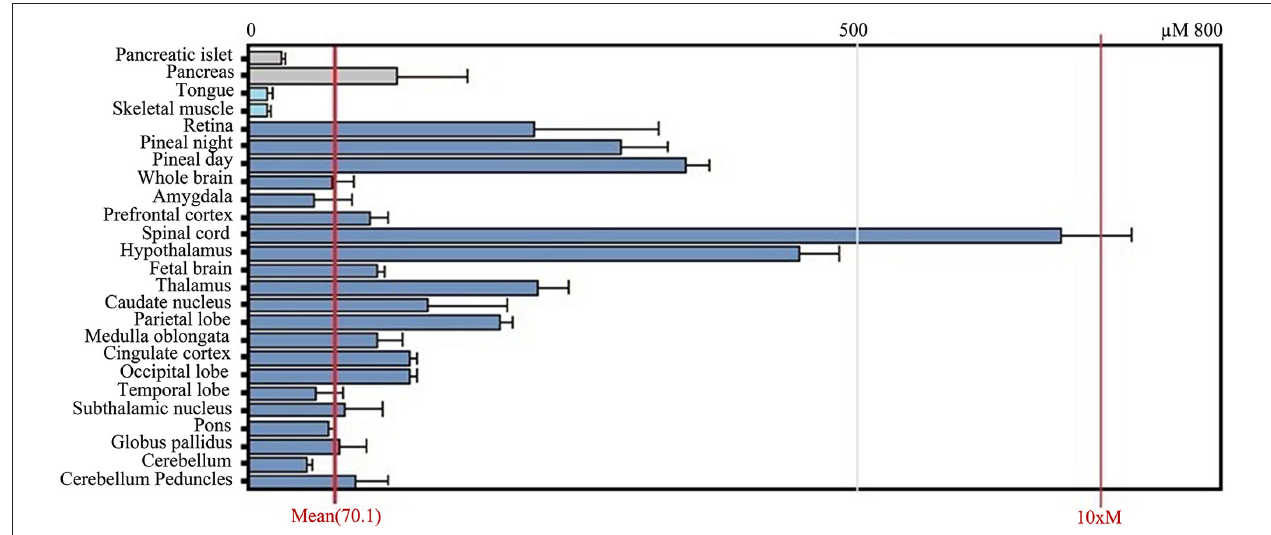
FIGURE 3 | GeneAtlas BACE1 mRNA expression pattern in human tissues, adapted from BioGPS.org [accessed on 2014-04-07] . The BACE1 mRNA is predominantly expressed in brain tissues such as the spinal cord and hypothalamus, but also in the pancreas.